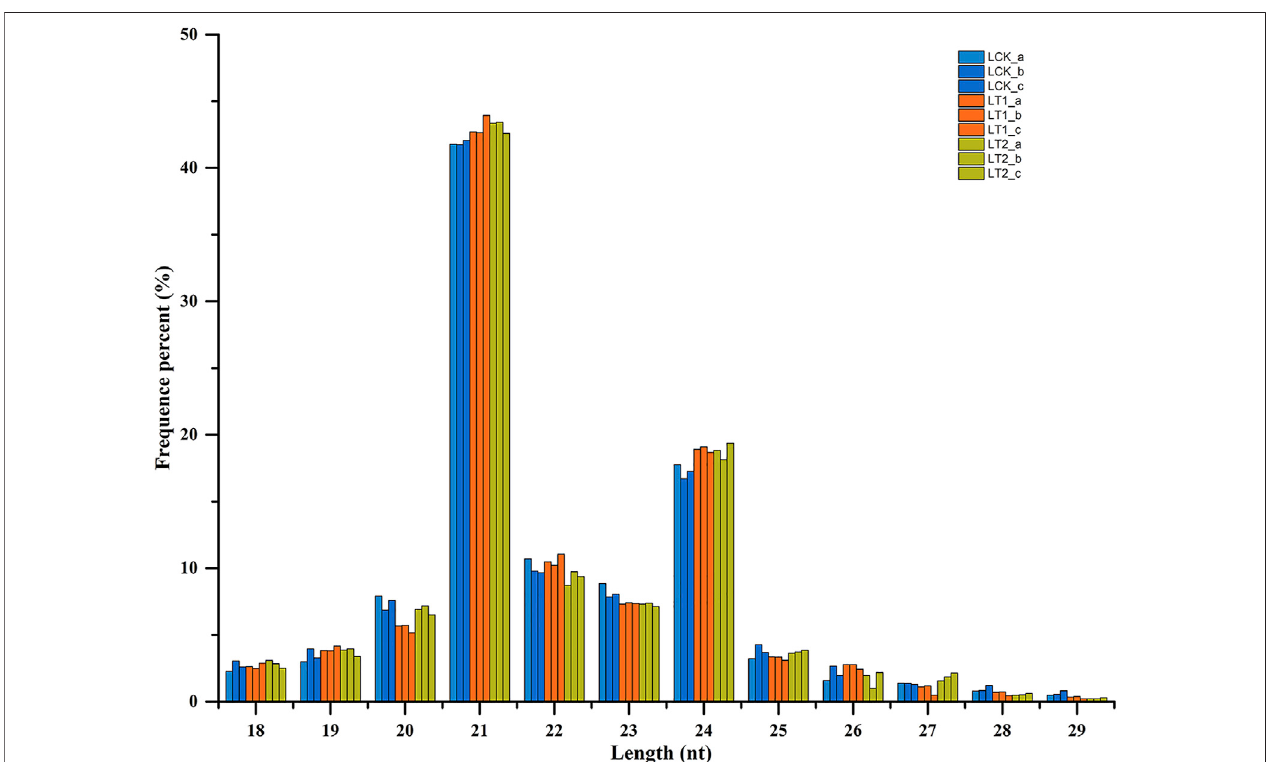
FIGURE 1 | Size distribution of small RNA sequences in different libraries. nt,